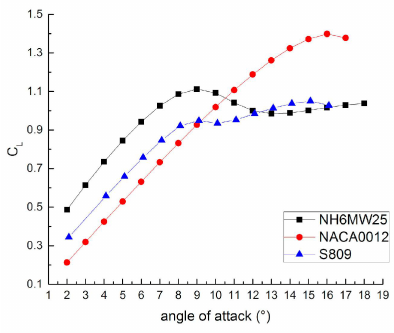
Figure 14. Comparison of lift coe ffi cient curves between three airfoils at Re = 1 × 10 6 .